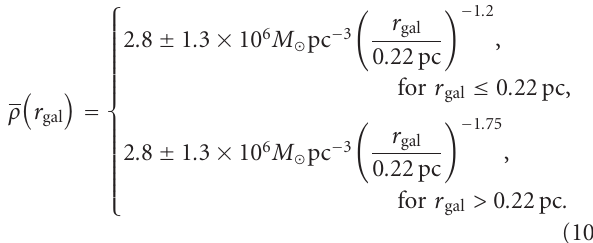
Figure 4: Mass-radius relations used in studies of calculating mass loss from stars due to stellar collisions. The thin lines are power-law relations of power-law index 1.0, 0.8, and 0.85 used by Rauch [33], Lai et al. [32], and Benz and Hills [31], respectively. The dotted line is the relation used by Freitag and Benz [38], and the thick line is the relation used in this